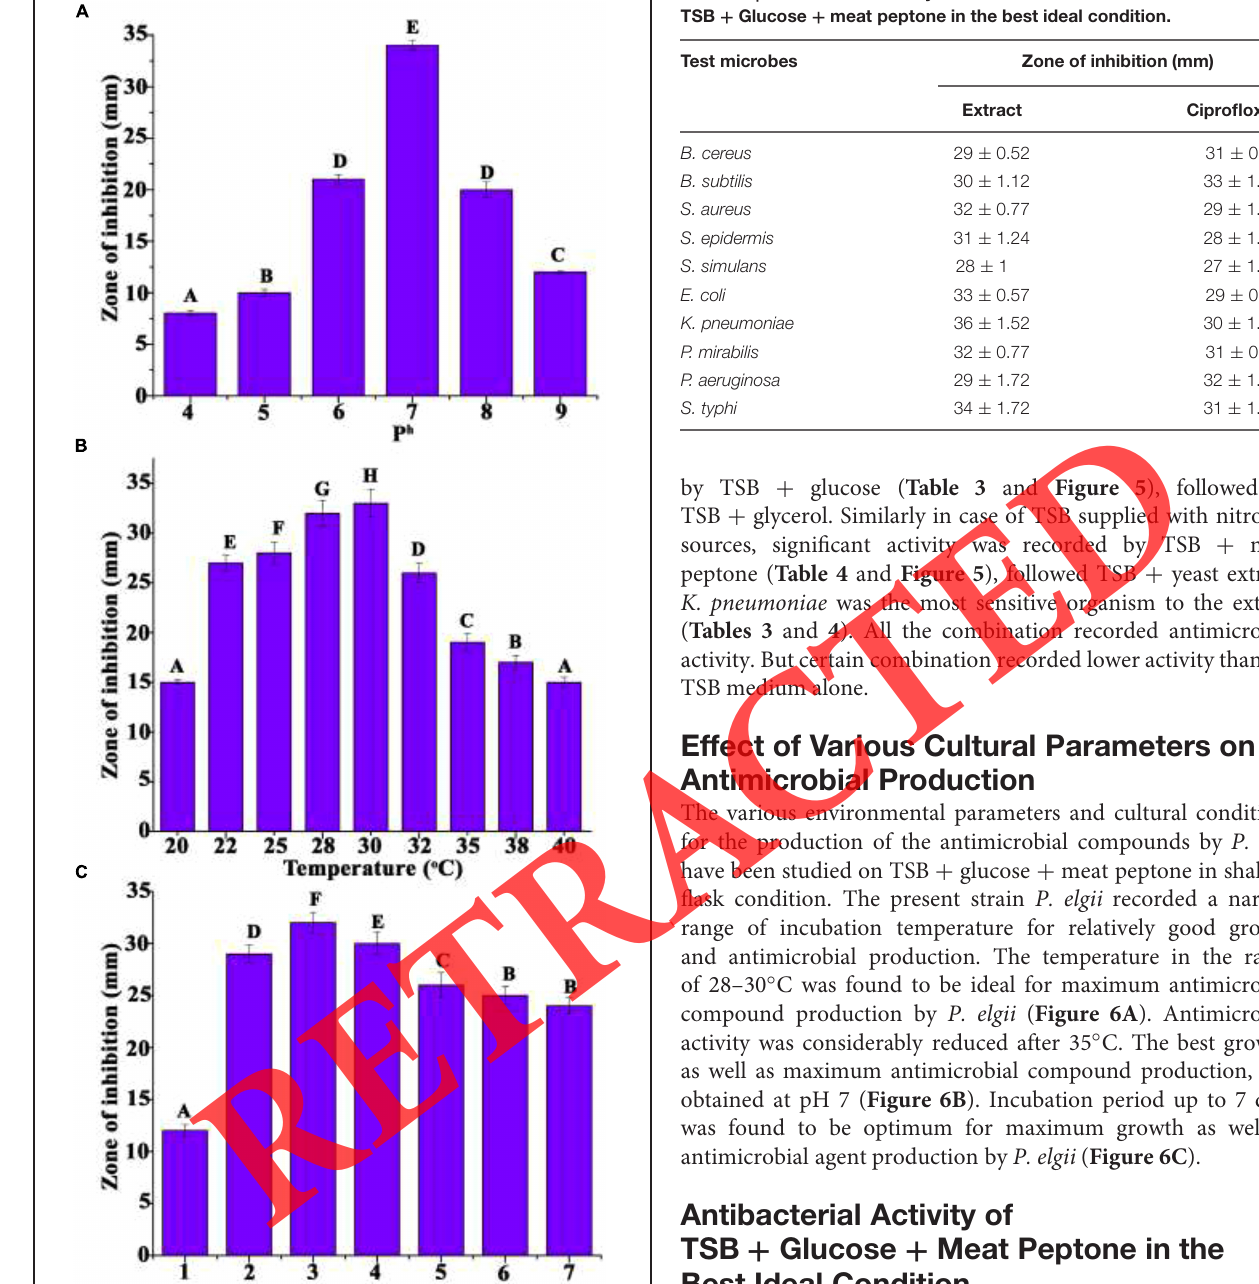
different nitrogen sources, the highest yield was recorded by TSB + meat peptone ( Figure 4B ).